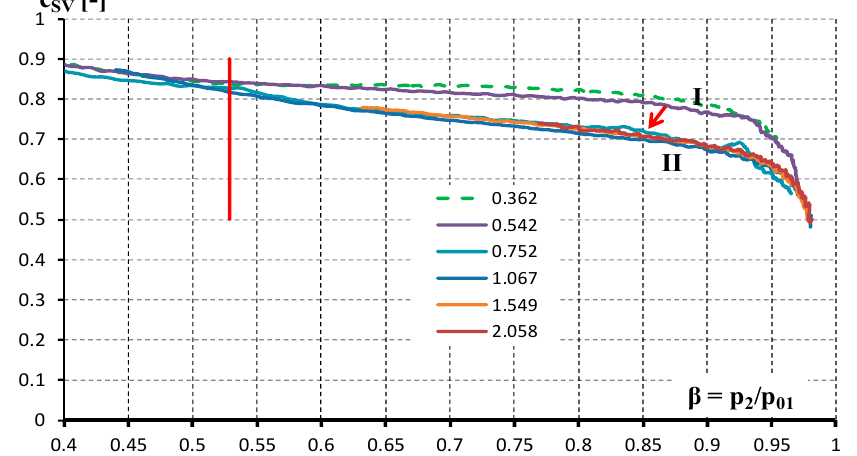
Figure 3. Values of the flow coefficient c SV in the function of the pressure ratio for radial clearance (RC) from 0.362 to 2.058 mm.